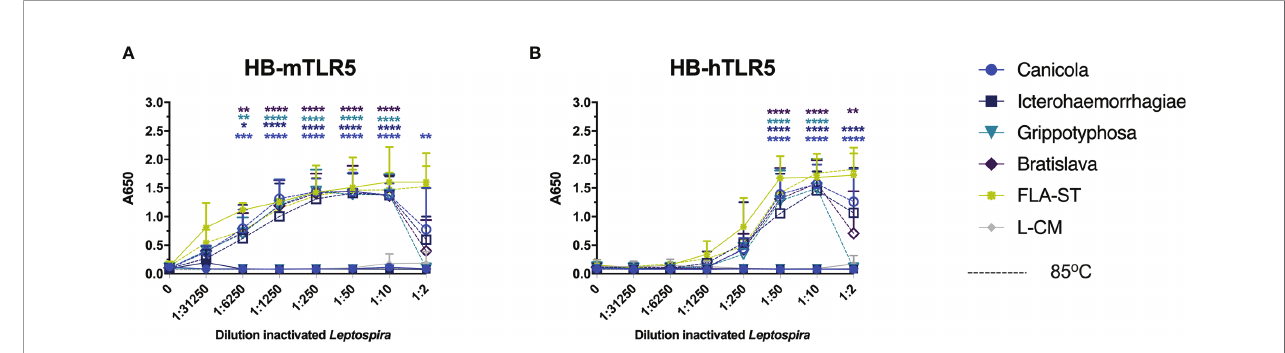
FIGURE 6 | Heat-treated Leptospira activate TLR5. HEK-Blue reporter cells expressing (A) mouse (HB-mTLR5) and (B) human (HB-hTLR5) TLR5 were stimulated for 24 h with serially diluted FLA-ST (yellow) or leptospiral culture medium (L-CM; grey) as positive and negative controls, respectively or whole-inactivated L. interrogans serogroup Canicola (circle), Icterohaemorrhagiae (square) or Bratislava (diamond) or L. kirschneri serogroup Grippotyphosa (triangle), that were either heat-treated at 85°C (dotted lines with open symbols) or left untreated (solid lines with closed symbols). Mean values from three independent assays per cell line are shown. Each assay was performed using two or three replicates per condition. The error bars represent the SD. A mixed-effect analysis combined with Tukey ’ s multiple comparisons test was used to test for signi fi cance between the untreated and heat-treated stimulus at each dilution. *p < 0.05, **p < 0.01, ***p < 0.001, ****p <